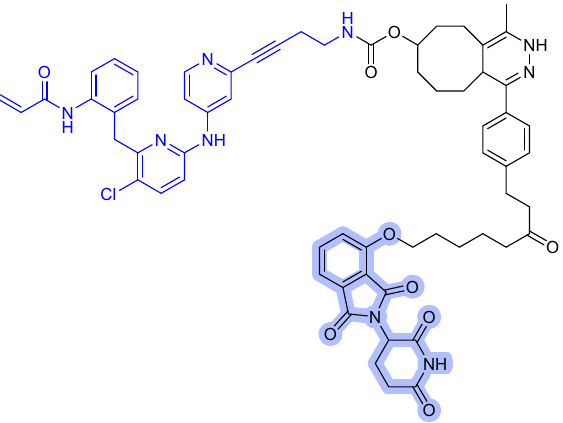
Figure 13. ERK-CLIPTAC. The colors show the part of each compound that it is a structurally important binding motif. The ligand of the POI is in blue. CRBN ligand is highlighted in purple.